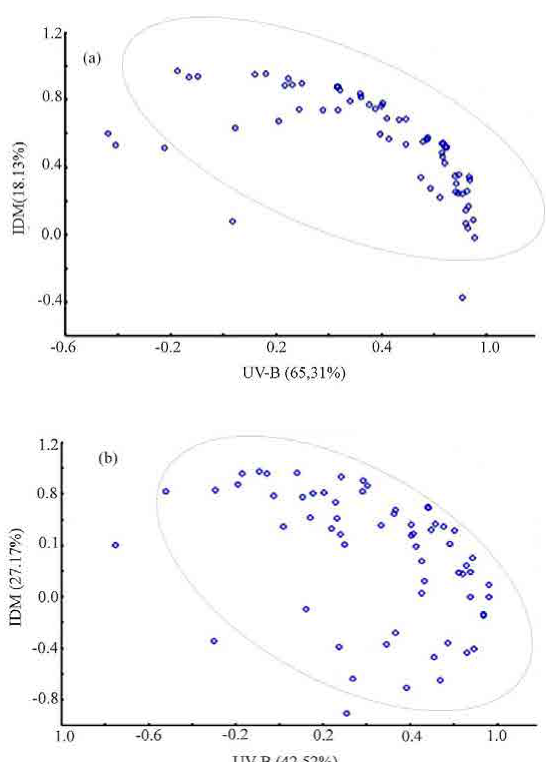
Fig. 7: 3D scatter plots visualizing a relationship between UV-B, temperature, and precipitation in groups (а) I and (b) II according to data the of the factor analysis of the MXD series variance for the period 1875-1974 using the varimax raw rotation